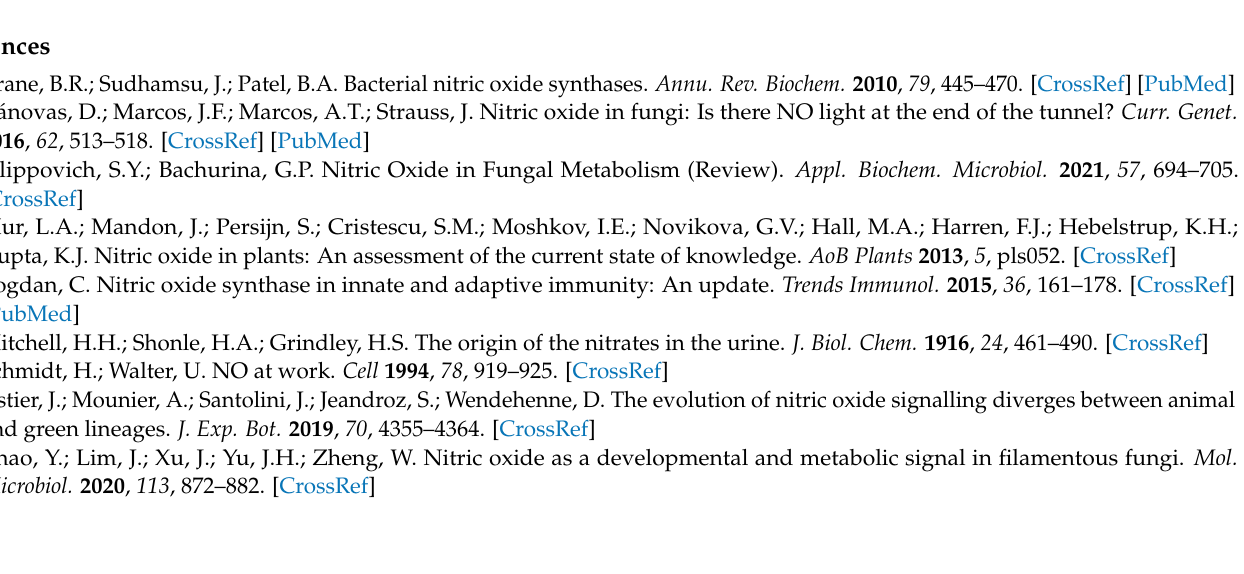
Bcfhg 1 strains; Table S5: DEGs exclusive to the comparison of non-exposed and NO-exposed B05.10 strain; Table S6: DEGs exclusive to the comparison of non-exposed ∆ Bcfhg 1 and NO-exposed ∆ Bcfhg 1; Table S7: DEGs common in the comparison of non-exposed and NO exposed BO5.10 strain and in the comparison of non-exposed and NO exposed ∆ Bcfhg 1